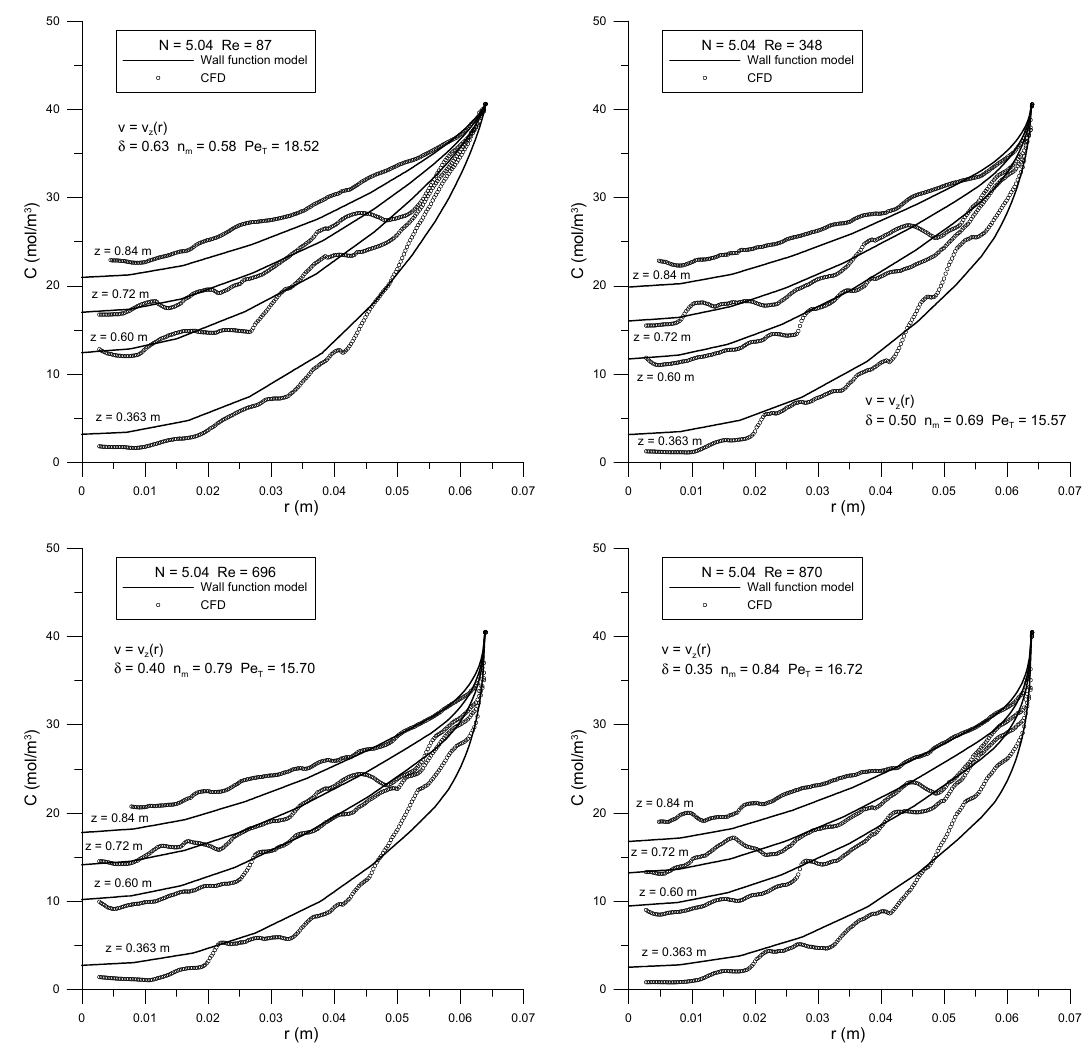
Figure 11. Results for three-parameter wall function model using D T ( r ) and v z ( r ) for the case N = 5.04, all four values of Re, each fitted to all four bed depths simultaneously.